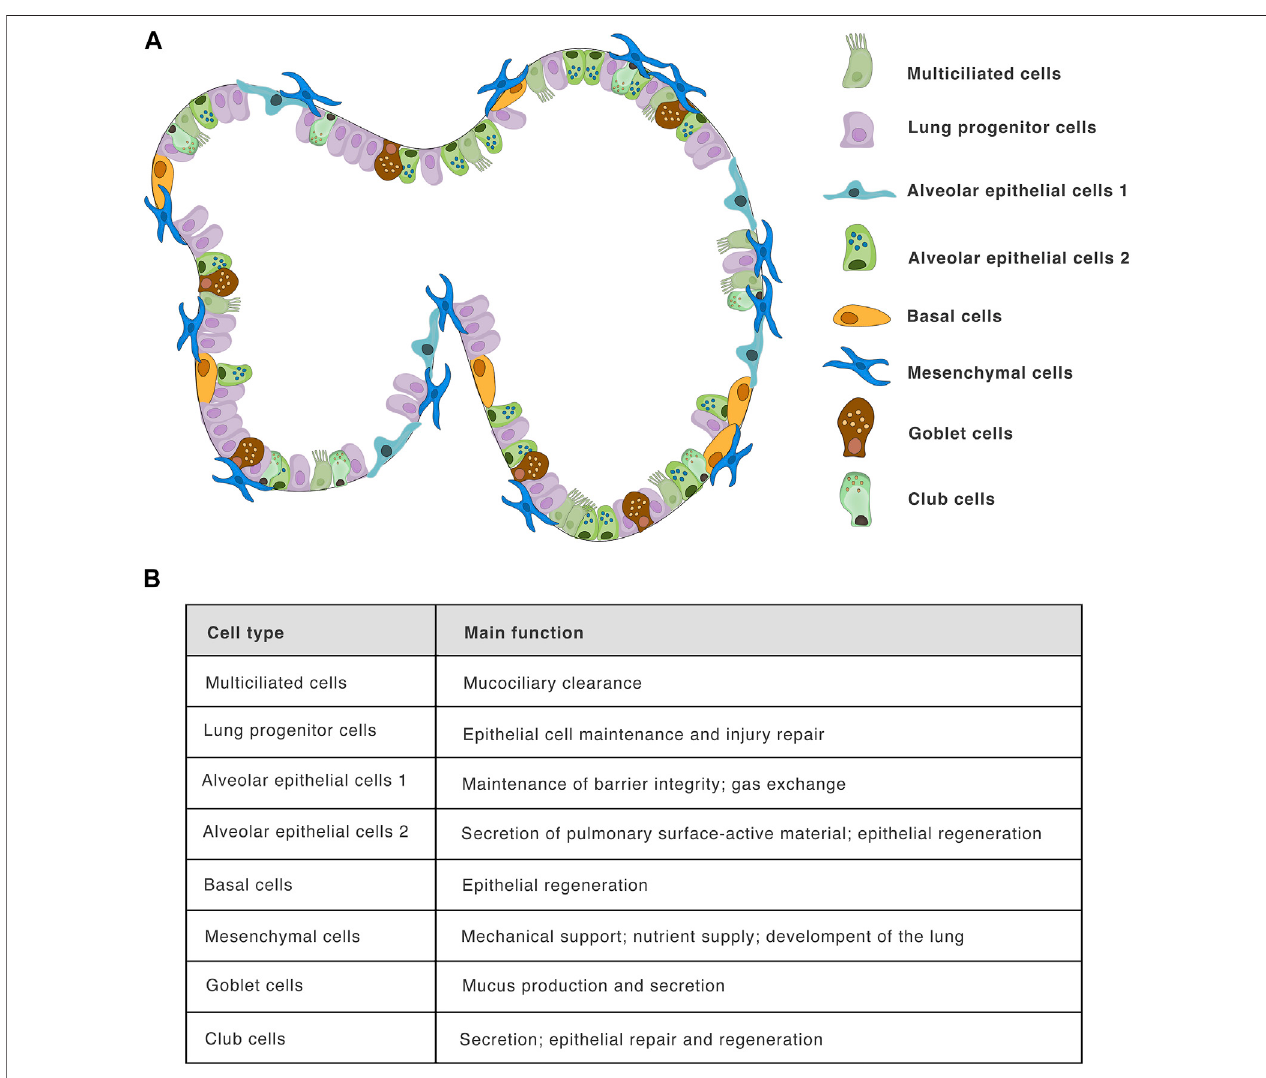
FIGURE 4 | Lung iPSC-derived organoid composition: (A) — The structure of human LOs and their cellular composition. The scheme shows selected major cell types forming in published iPSC-derived LOs models, including club cells, goblet cells, basal cells, alveolar epithelial cells 1 and 2, multiciliated epithelial cells, lung progenitor cells, and mesenchymal cells. While human lung tissue comprises more than 40 different cell type, including in fi ltrating immune cells, the iPSC-derived organoids models provide unique opportunity to study the “ tissue ” without the in fi ltrating hematopoietic cells. Although, iPSC-derived organoids represent excellent in vitro model, they do not fully mimic the human lung tissue complexity. (B) — Main function of mentioned cell types in human the lung.